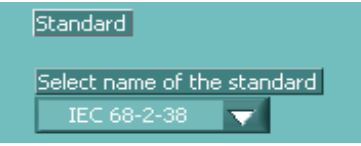
Figure 8. Selecting standard.